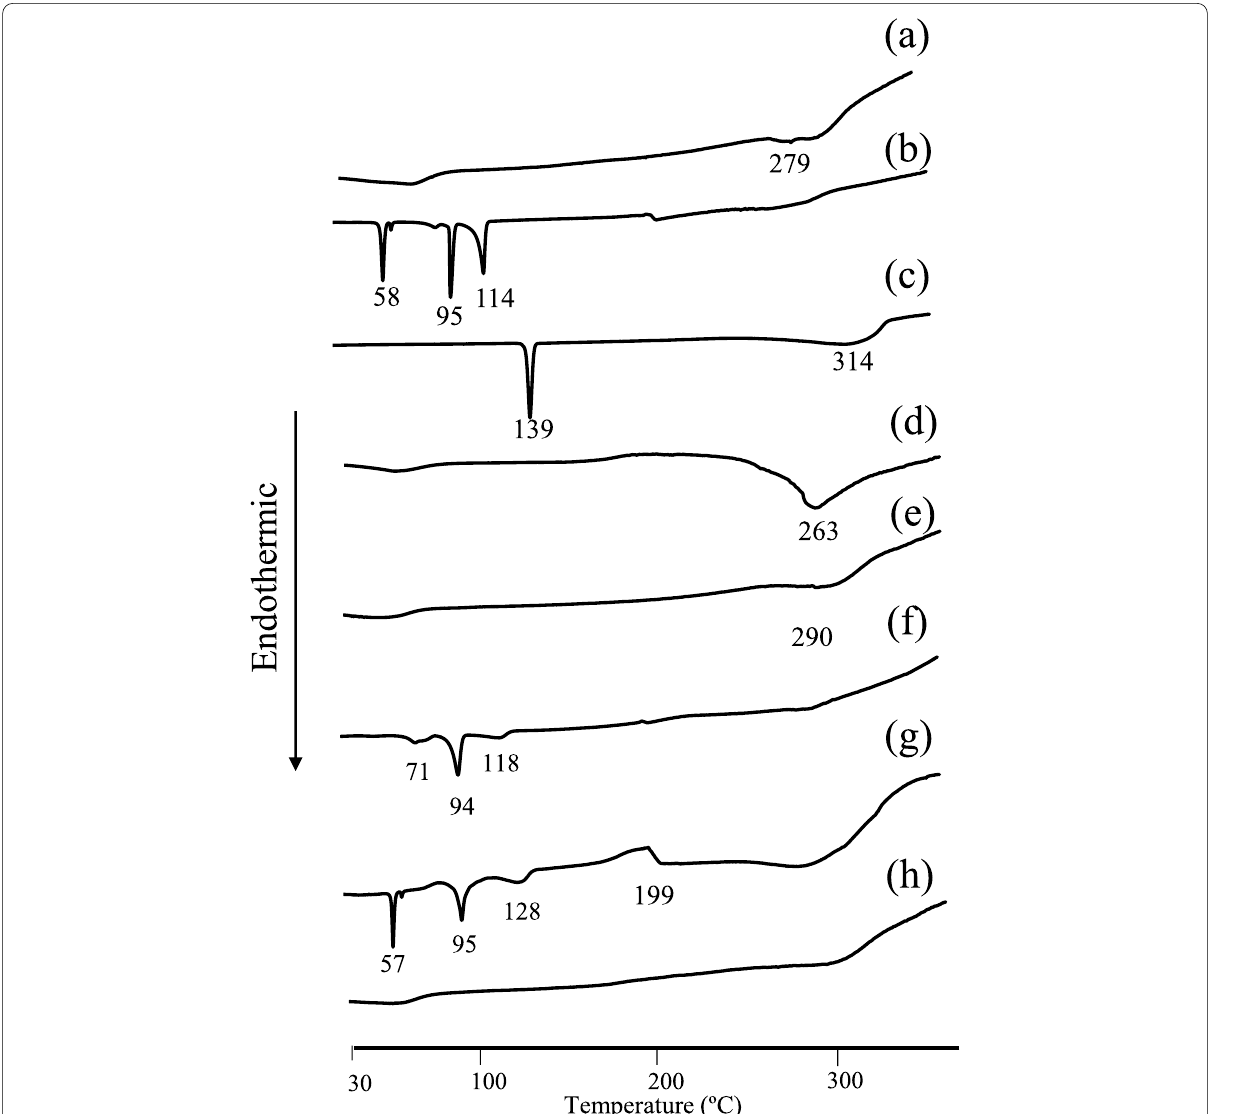
Fig. 7 DSC curves of Sol/ASC-DP/NOB systems. a Sol, b ASC-DP, c NOB, d EVP (Sol/ASC-DP 1/1), g PM (Sol/ASC-DP/NOB